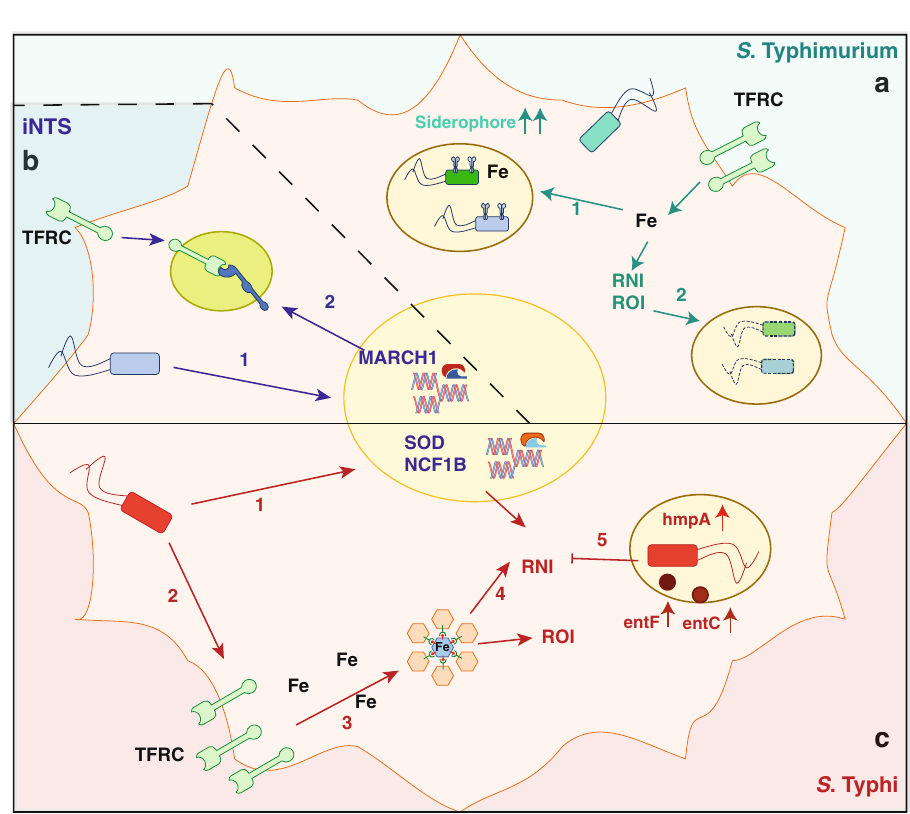
Fig. 7 Strategies adopted by Salmonella to prevent iron-driven bactericidal mechanisms. a S . Typhimurium overexpress different iron acquisition systems to compete for the intracellular iron (1). Excess of iron can be used by the host to generate antimicrobial mechanisms which improve bacterial clearance (2). b Non-typhoidal Salmonella limit intracellular iron loading by reducing surface expression of TFRC most likely through the action of MARCH1 (1 and 2). c Infection with S . Typhi results in increased iron loading and activation of oxidative and nitrosative stress mechanisms (1 – 4). However, the higher production of detoxifying enzymes, such as HmpA (5), protect the bacteria by the toxic effect of RNI. Enterobactin (entF and entC) are responsible of iron acquisition during stress